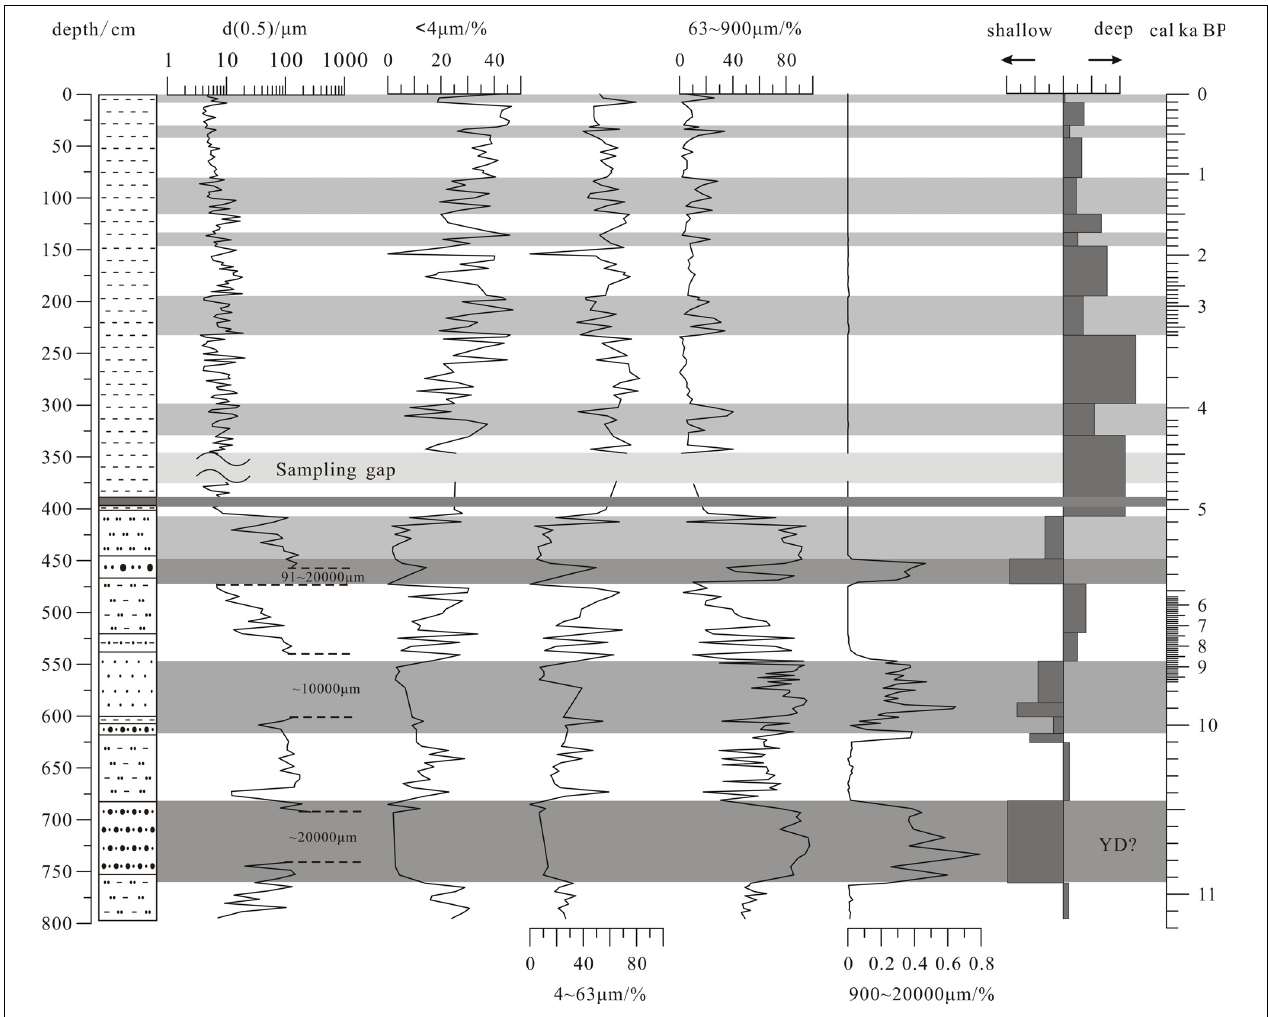
FIGURE 4 | Grain size changes in TGN-05 sediments since the last